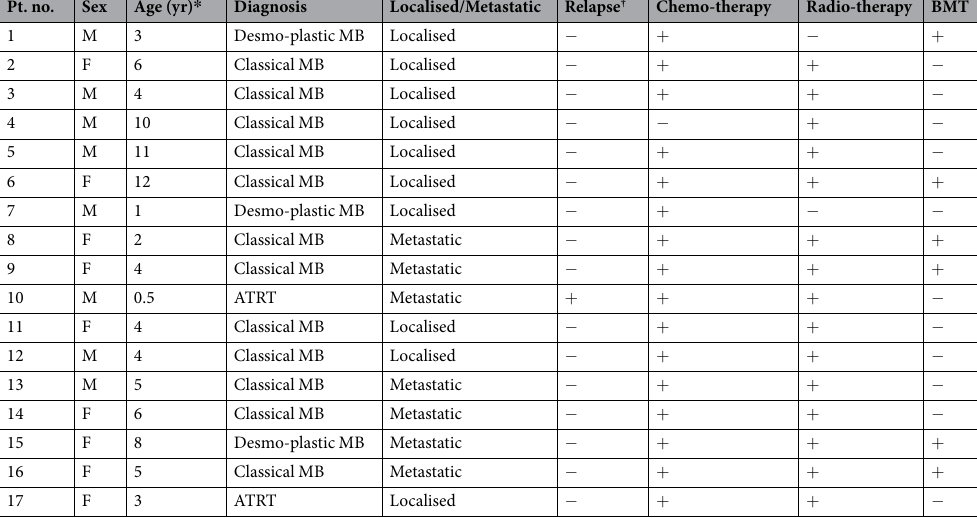
Table 1. Demographic and clinical data of the study group. * At diagnosis. † As of completion of this study. BMT, bone marrow transplantation, MB, medulloblastoma, ATRT, atypical teratoid/rhabdoid